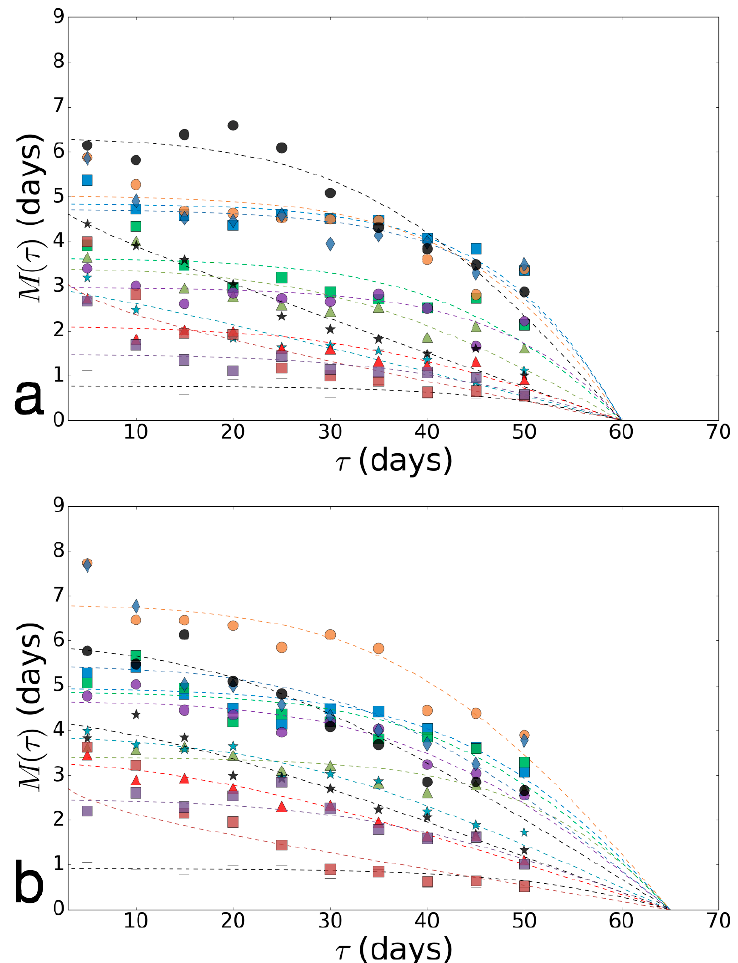
Figure 3. Results of Cox regression calculation for the D. melanogaster after exposure to different stressors regardless of the sex of the individual. ( a )—indicates regression of the risk for flies under the influence of each stressor when the factor is solely the stress, excluding the age of the individual. We have accepted the exposing to paraquat males at the age of 5 days at a basic level. ( b )—shows the regression of risk for flies under the influence of each of the stressors, with an estimate of the impact of interacting factors (stressor and age of flies). 1.00 hazard ratio, in this case, means no influences of age on the death risk ratio for each